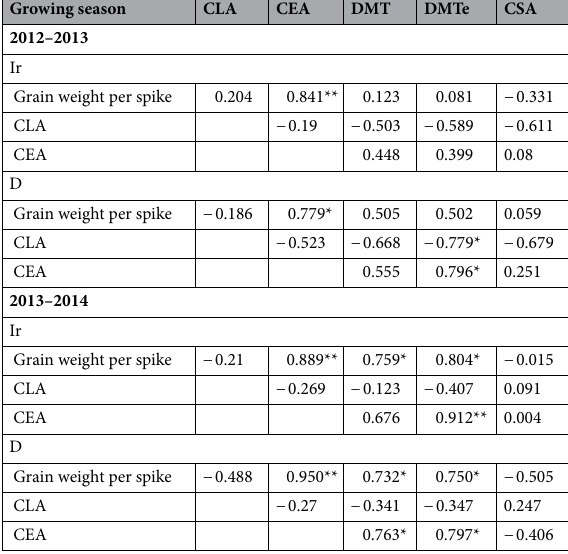
Table 5. Correlation of the ear and leaf contribution to grain weight with biological indicators. With the same increasing or decreasing trend, data that did not include the shaded ear in the leaf contribution to grain weight were solely considered and data that did not include defoliation in the ear contribution to grain weight were solely considered; data regarding the CK treatment for grain weight per spike were only considered; *significant at P < 0.05; **significant at P <